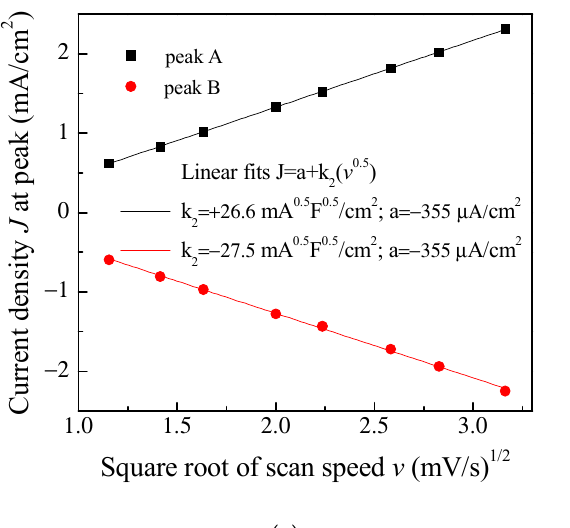
Figure 9. Current density–voltage loop of the same Au/PPy:DBSA/Nafion:LiPs/PPy:DBSA/Au cell that Figure 8 refers to measured at different scan speeds. The arrows mark the forward (A) and reverse (B) current density peaks, the intensity of which is reported in Figure 10a. The vertical lines marked c and d in the flat region of the inner loop identify the voltage V c (V d ) at which the forward (reverse) current density data displayed in Figure 10b are taken from.